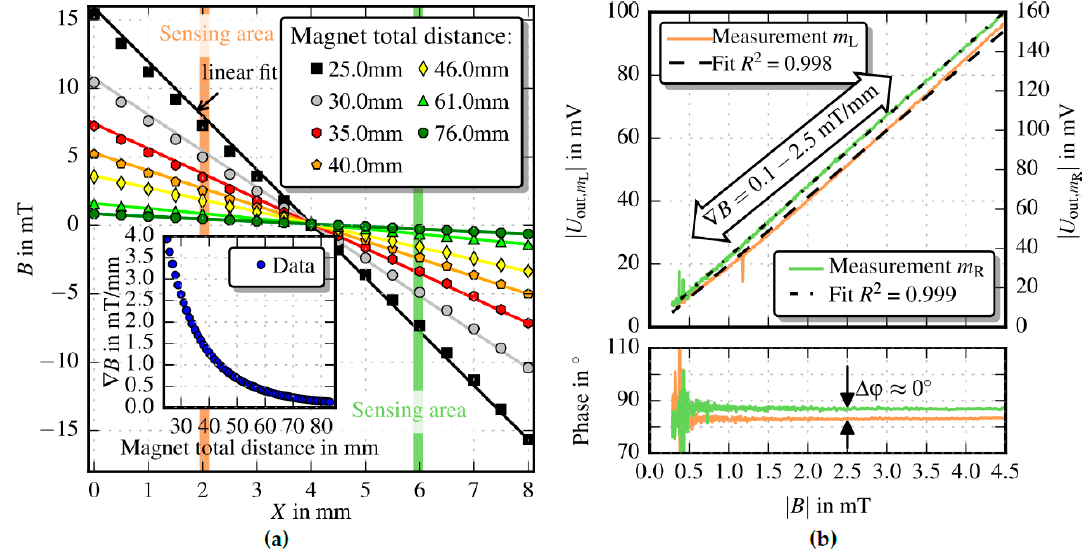
Figure 4. ( a ) Depicts a few selected gradient fields which occurs in the vicinity of the sensor’s masses, measured by a Hall probe and the total amount of measured ∇ B in dependency of d Magnet (inset). The masses’ sensing areas are indicated orange and green for m L and m R , respectively. ( b ) Sensor’s output signals, where a phase difference of 0 ◦ denotes opposed oscillation of the masses and, hence, a present gradient field (obtained with Equation